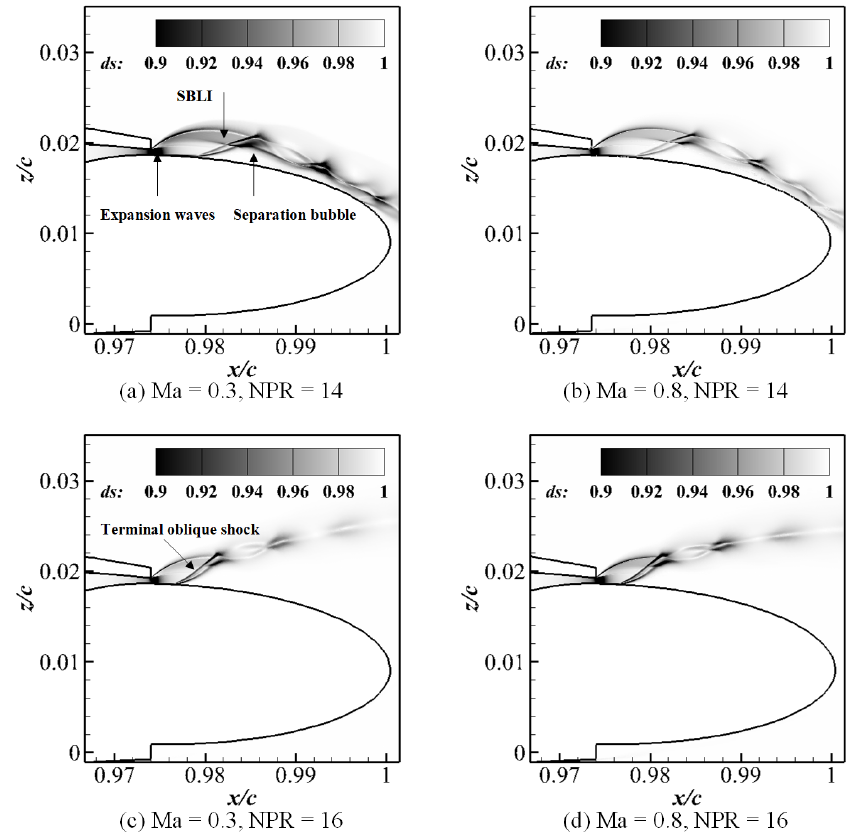
Figure 15. Density gradient fields of the jet along the Coanda